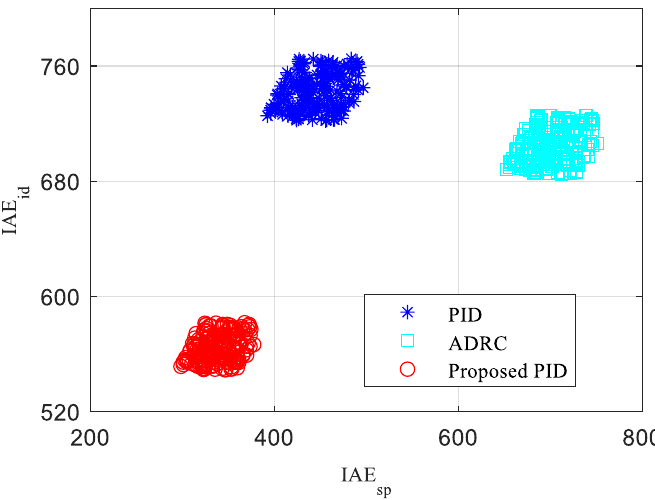
Figure 14. IAE sp and IAE id distribution under an operating condition of 100% load.